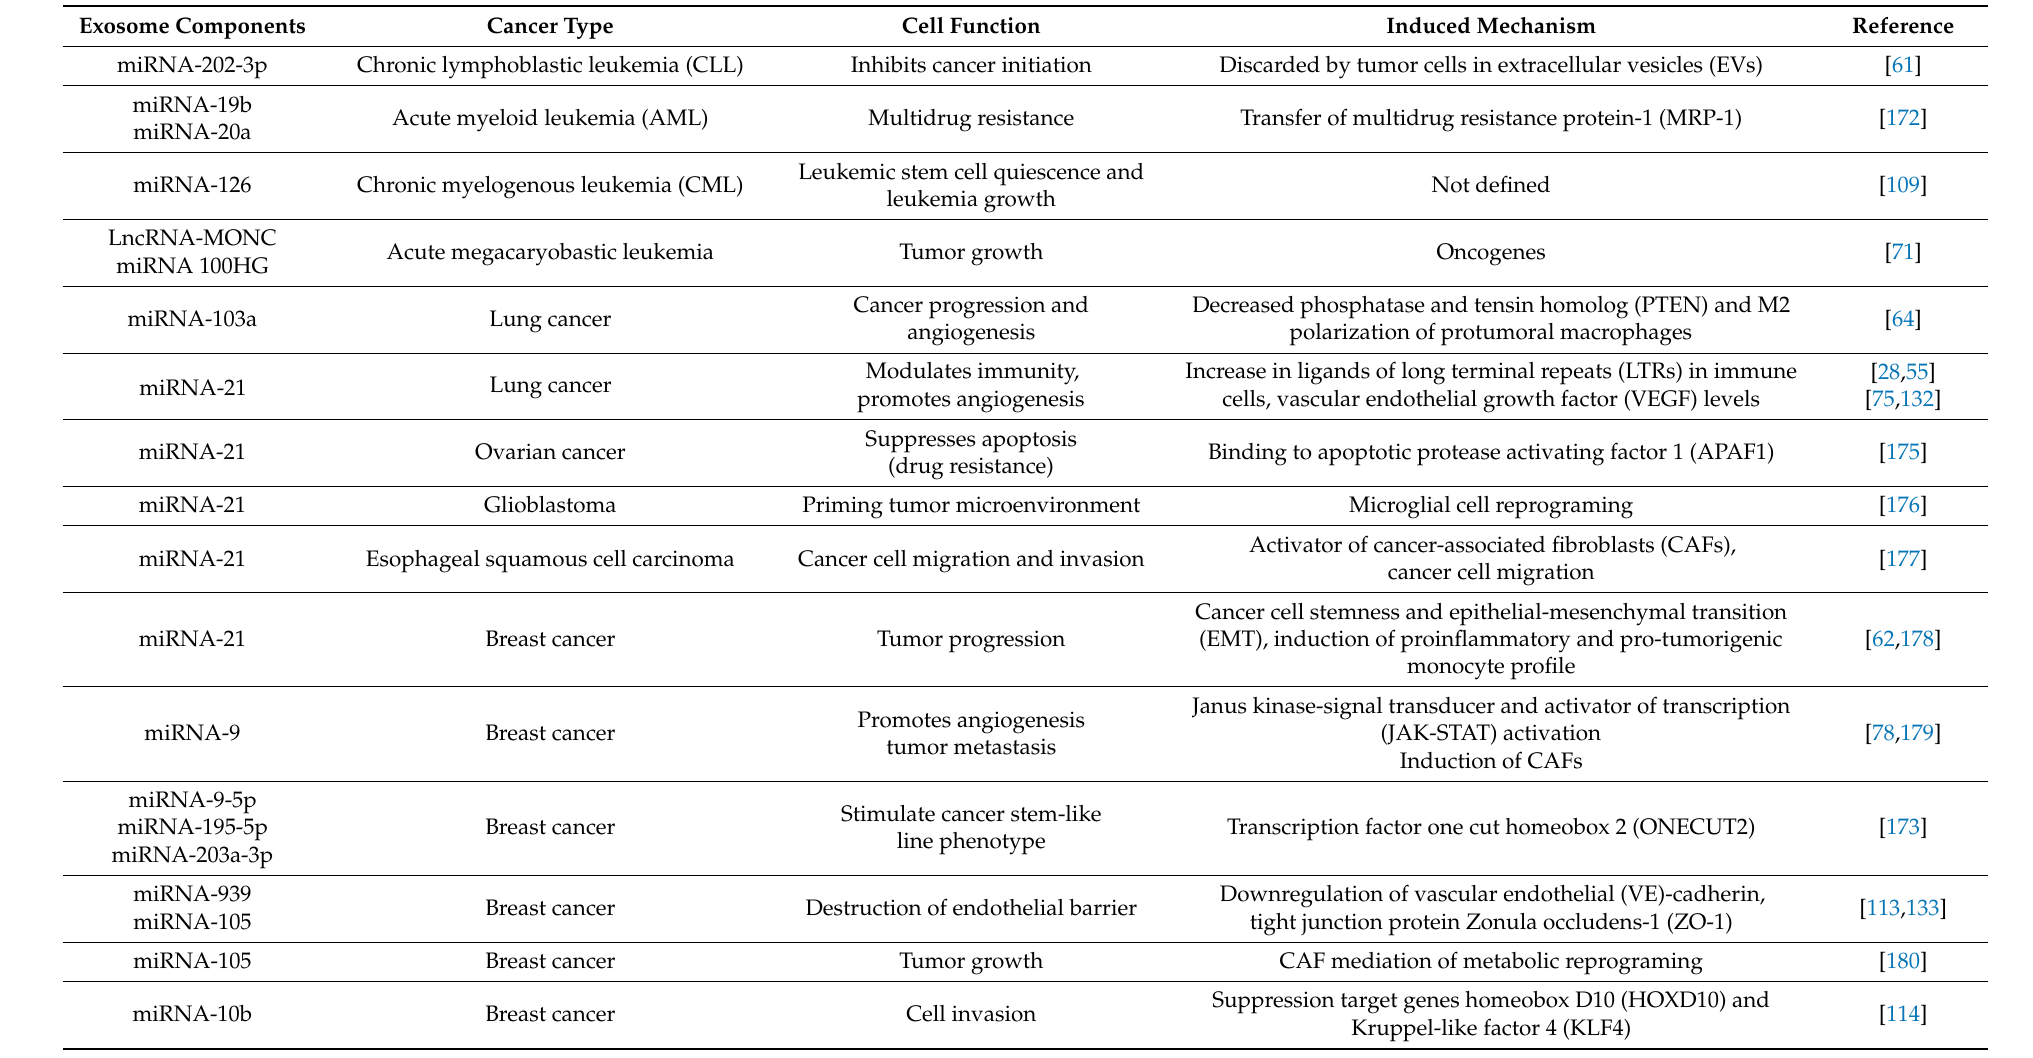
Table 1. Roles and mechanisms of microRNAs (miRNAs) and long noncoding (lnc)-miRNAs reported in cancer